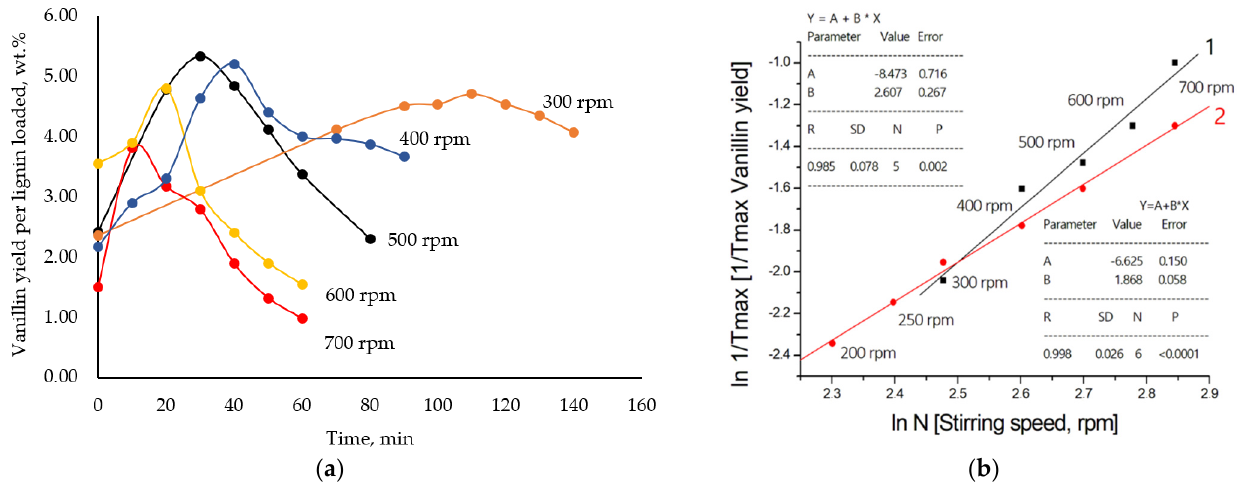
Figure 6. Influence of the stirring speed on the dynamics of vanillin accumulation in linear ( a ) and logarithmic ( b ) coordinates, during the oxidation of the original Belarusian flax shives with 2.5% (1) and 5% (2) [21] of NaOH. For the process conditions see Figure